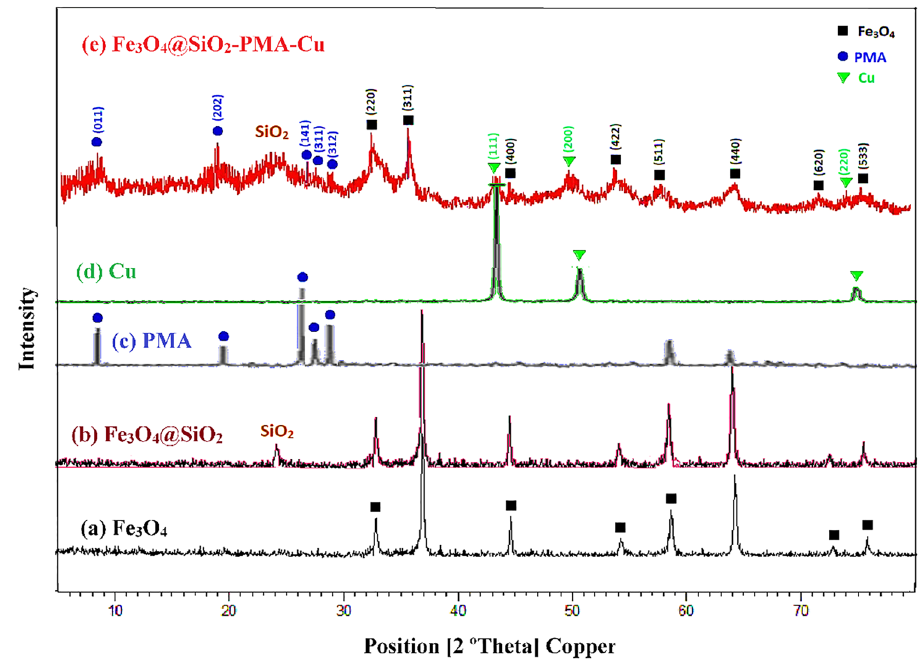
Figure 5. X-ray diffraction patterns of ( a ) Fe 3 O 4 , ( b ) Fe 3 O 4 @SiO 2 , ( c ) PMA, ( d ) Cu and ( e ) Fe 3 O 4 @SiO 2 -